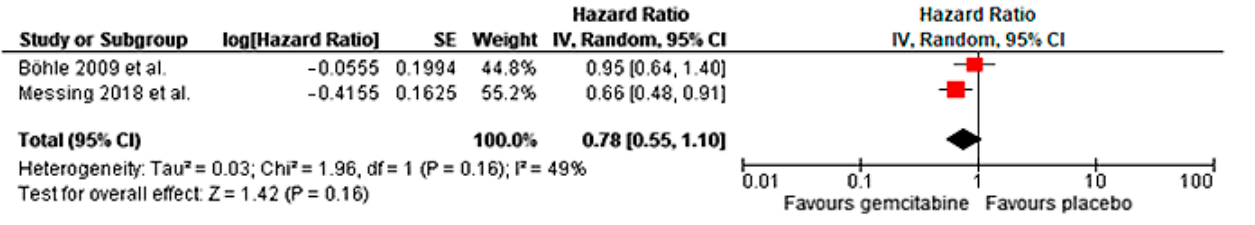
Figure 2. Forest plot showing the outcomes of the meta-analysis.